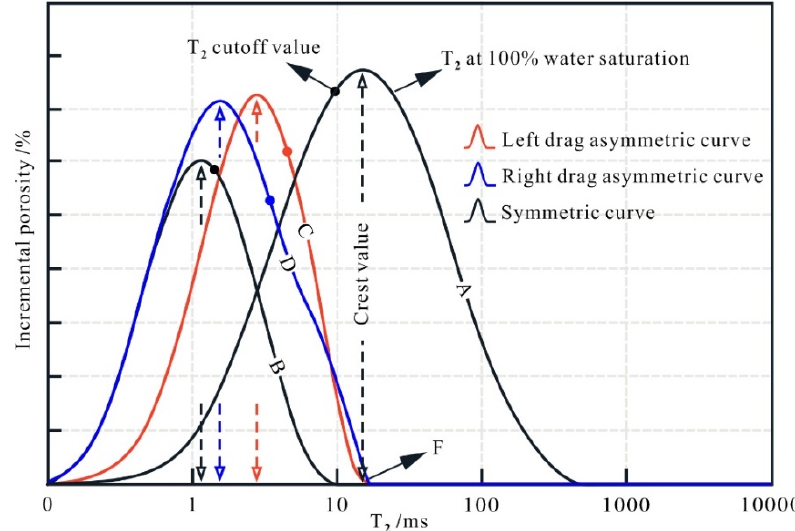
Figure 11. T 2 spectra of unimodal morphological at 100% water saturation.